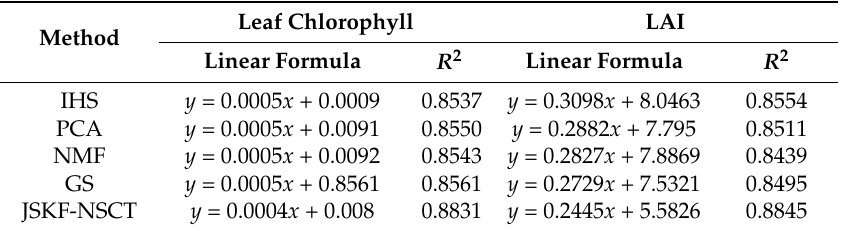
Table 11. Results of comparison at Stage